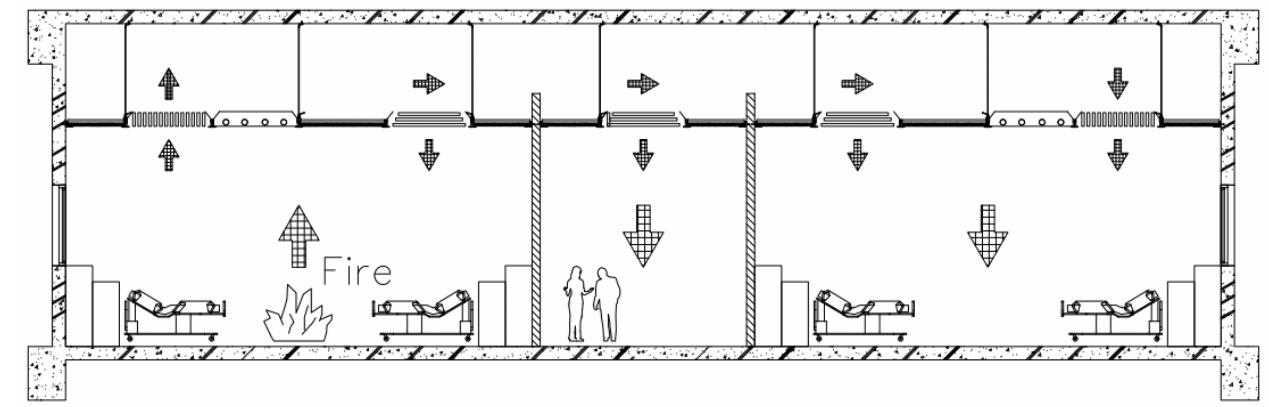
Figure 1. Schematic diagram of the smoke leakage path from the